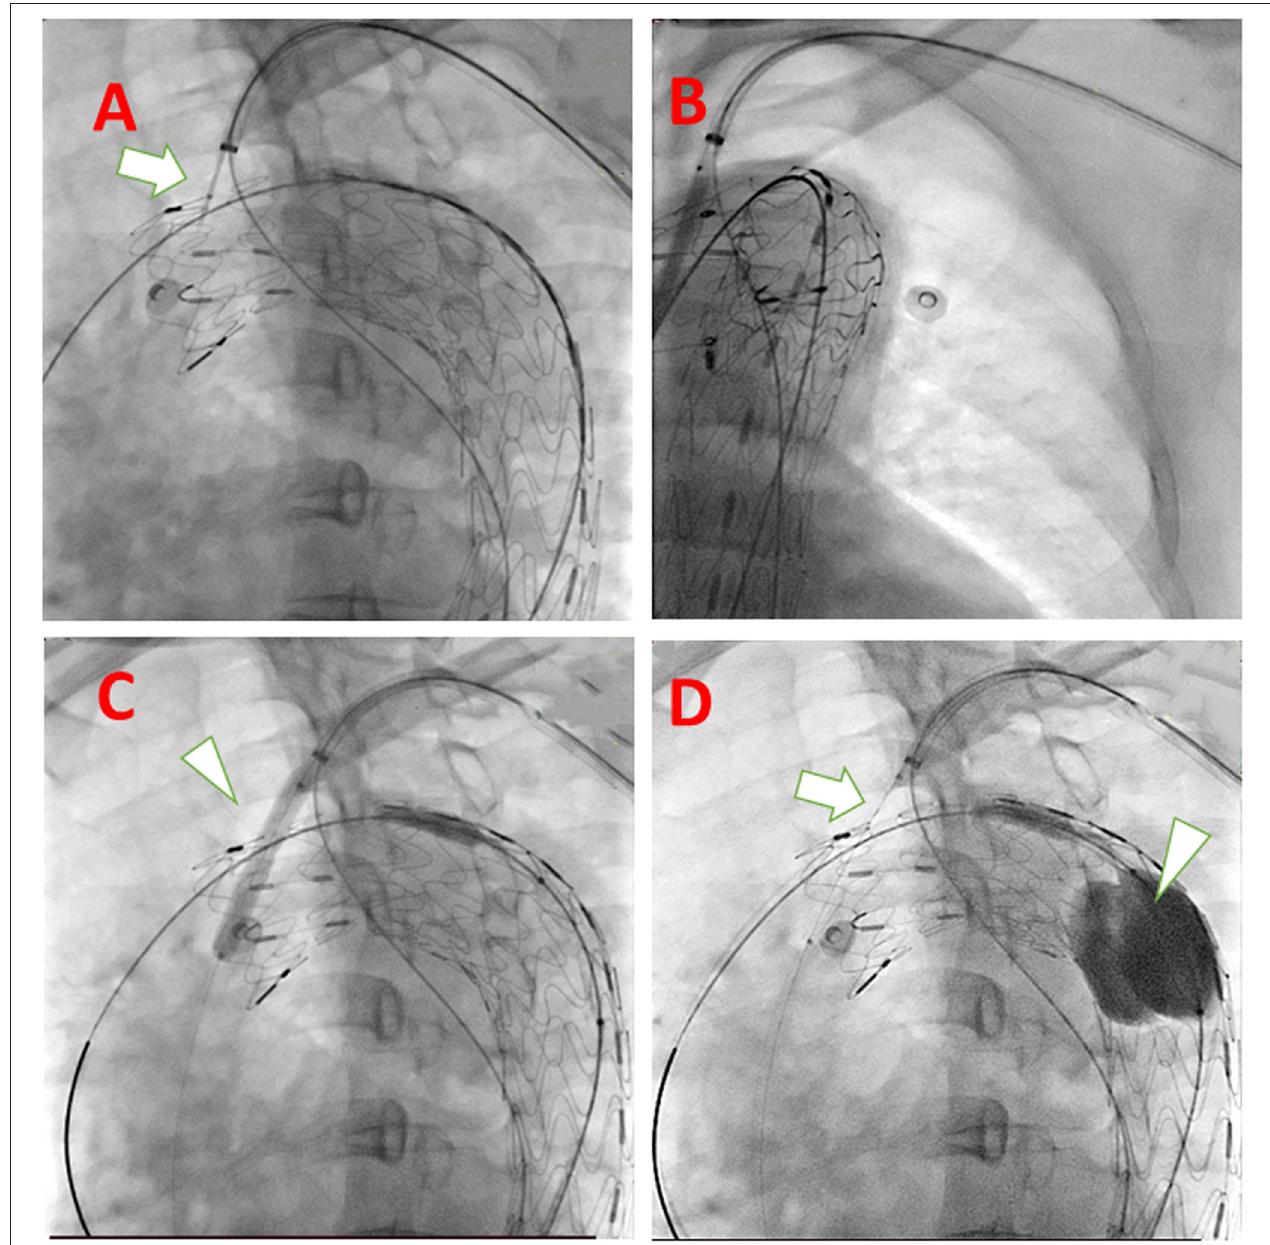
FIGURE 3 | Technical spots mentioned in the system deployment procedure. (A) Puncture needle with descending strengthen wire in the same long sheath when puncturing (white arrow); (B) rotate the tube and make sure the guidewire and expanding balloon into the fenestration is in the lumen of the aortic stent graft; (C) Using larger diameter balloon (white arrowhead) to expand the fenestration; (D) Insert the delivery system of C-skirt stent graft (white arrow) and to prevent migration of aortic stent-graft, a Tri-lobe balloon (white arrowhead) is expanded if necessary.